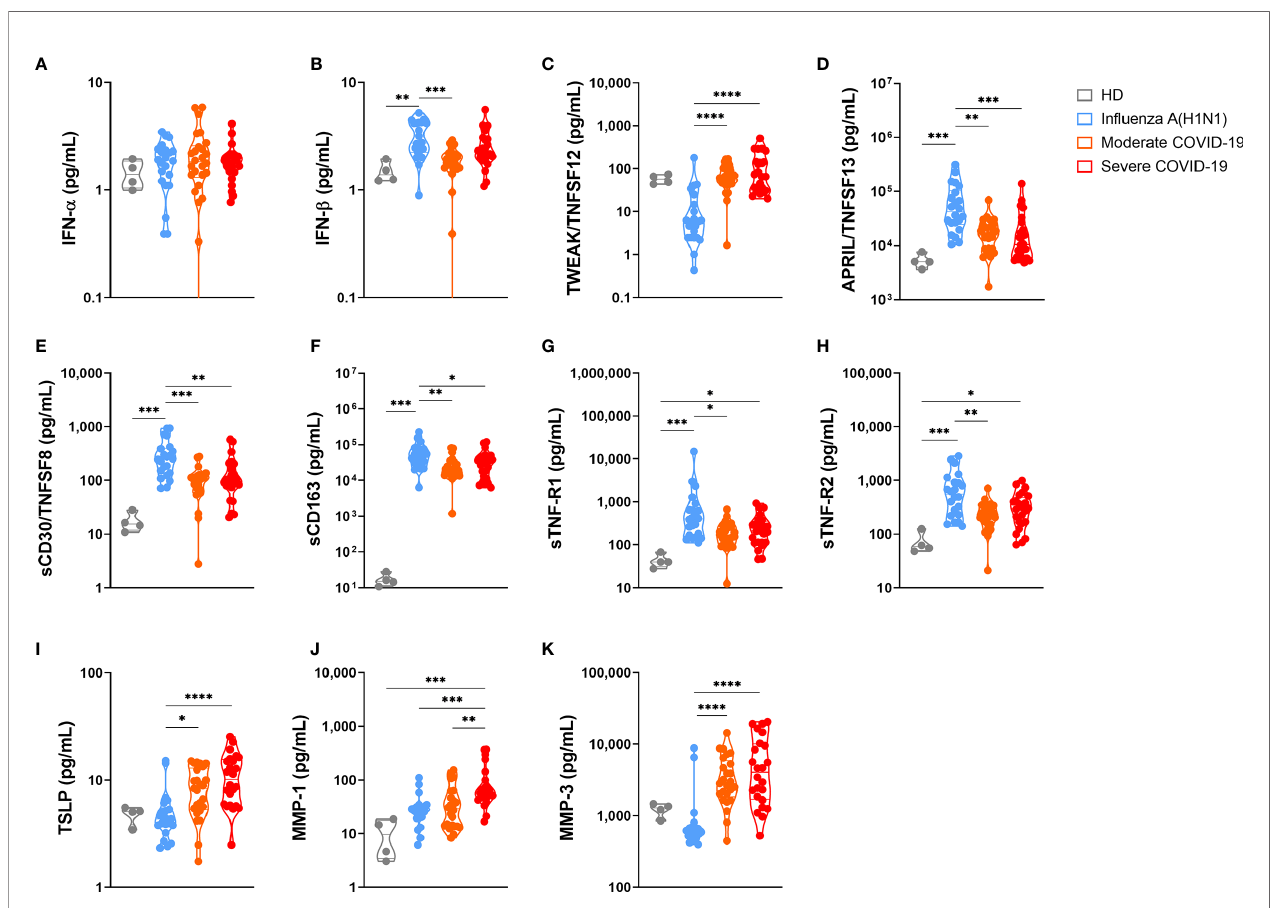
FIGURE 8 | Immune mediators in the plasma of patients with pandemic in fl uenza A(H1N1) and COVID-19. Levels of different soluble immune mediators in plasma samples from patients with COVID-19 (n=25 moderate, 24 severe) and pandemic in fl uenza A(H1N1) (n=23), as well as in samples from healthy volunteer donors (HD, n=4) were assessed by Luminex assay. Violin plots display medians and interquartile ranges (IQR). Differences between groups we estimated using the Kruskal-Wallis test with post hoc Dunn´s test. Signi fi cant differences are denoted by bars and asterisks: *p ≤ 0.05, **p ≤ 0.01, ***p ≤ 0.001, ****p ≤ 0.0001. (A) IFN- a , interferon- alpha; (B) IFN- b , interferon-beta; (C) TWEAK/TNFSF12, tumor necrosis factor-like weak inducer of apoptosis/tumor necrosis factor ligand superfamily member 12; (D) APRIL/TNFSF13, A proliferation-inducing ligand/tumor necrosis factor ligand superfamily member 13; (E) sCD30/TNFRSF8, soluble CD30/tumor necrosis factor ligand superfamily member 8; (F) sCD163, soluble CD163; (G) sTNF-R1, soluble tumor necrosis factor receptor 1; (H) sTNF-R2, soluble tumor necrosis factor receptor 2; (I) TSLP, thymic stromal lymphopoietin; (J) MMP-1, metalloprotease 1; (K) MMP-3, metalloprotease